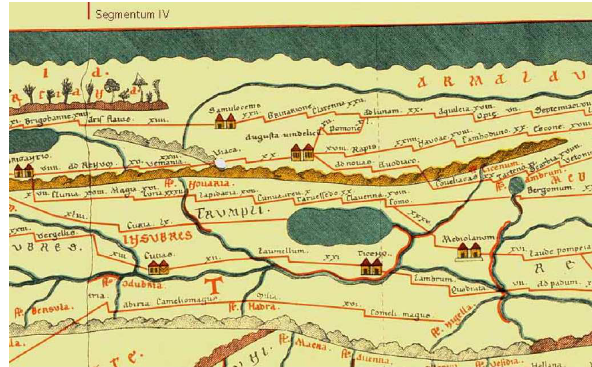
Figure 3. Example of POI 3D visualization and query